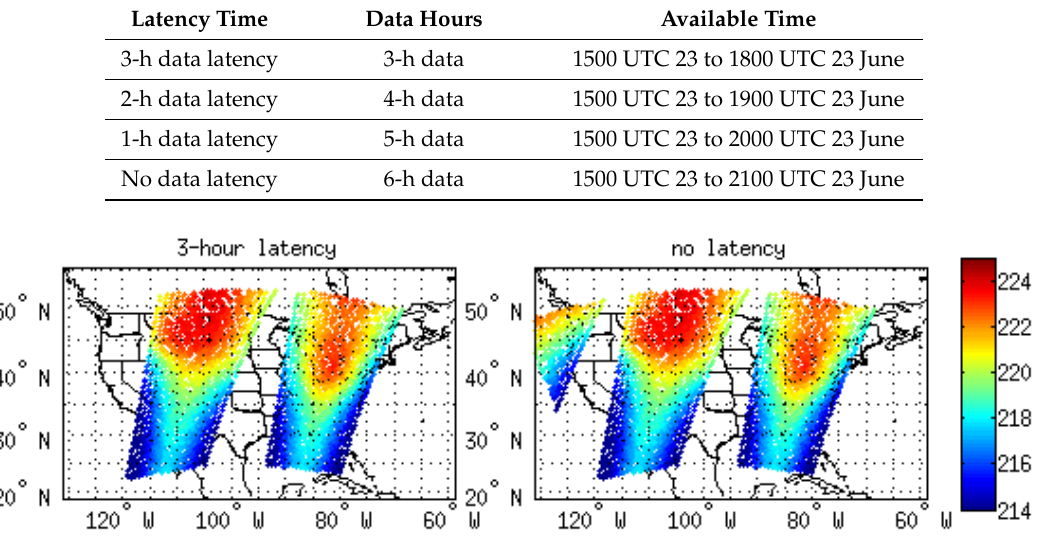
Figure 1. Channel 8 of AMSU-A onboard Metop-B data coverage for the 3-hour latency and 2-hour latency at 1800 UTC 23 June, 2018.